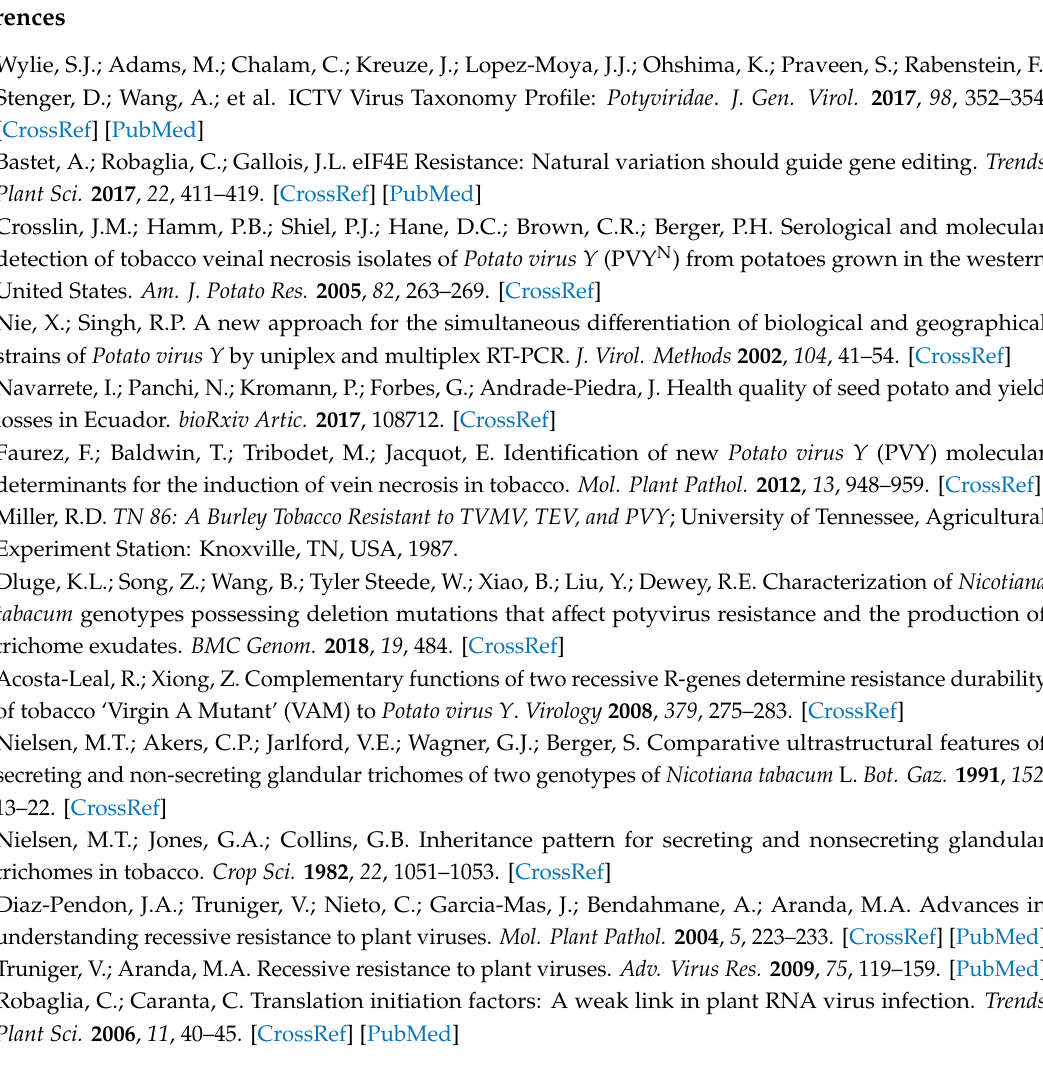
Figure S1: Mutation detection using capillary electrophoresis, Table S1: Primers used in PCR and dCAPS assay, Table S2: ELISA of PVY resistance of selected tobacco lines, Table S3: ELISA of PVY resistance of selected tobacco plants subjected to the inoculation of di ff erent potyvirus